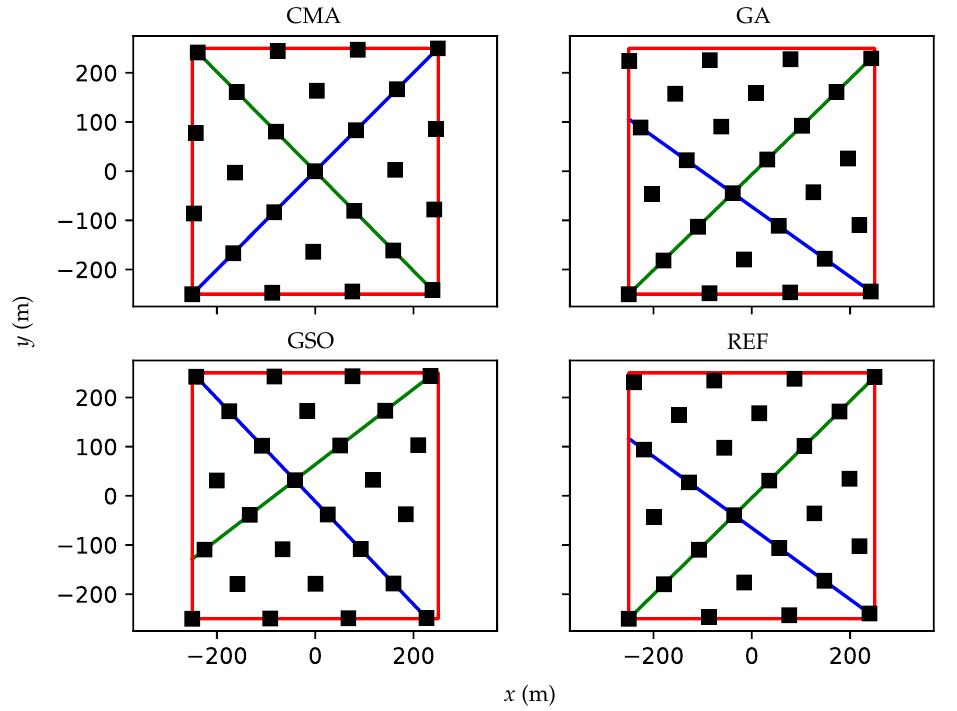
Figure 6. Best array layouts found by the optimisers and the reference layout